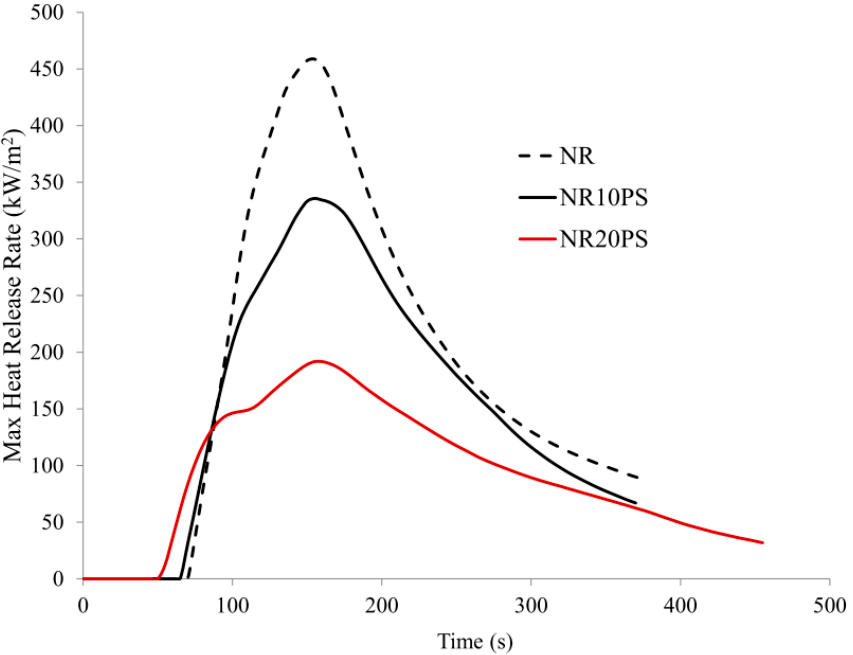
Figure 10. HRR max curves of NR rubber composites containing pure straw filler. Materials 2020 , 13 , x FOR PEER REVIEW